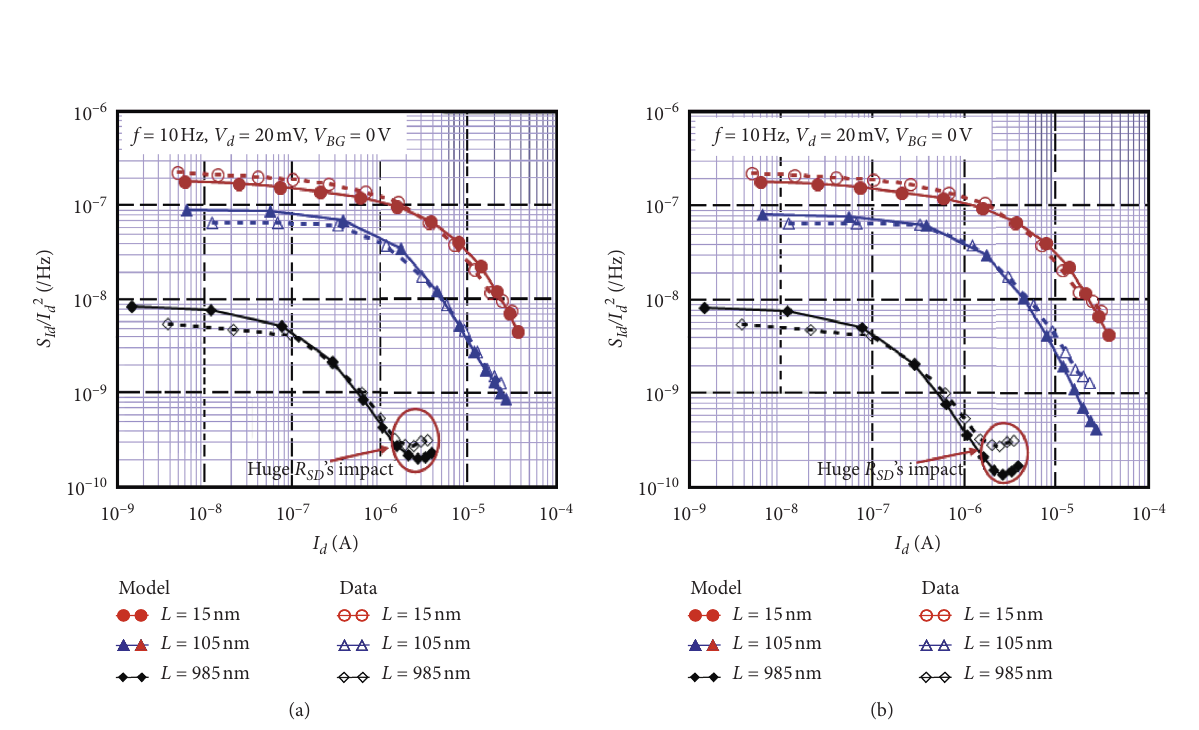
Figure 6: Comparison of experimental normalized drain current PSD versus I d with (a) CNF +CMF+ Δ r , 2D numerical simulation results, with RCS parameters, and with (b) CNF +CMF+ Δ r , semianalytical model results for 14 nm FDSOI samples, for some effective gate lengths.